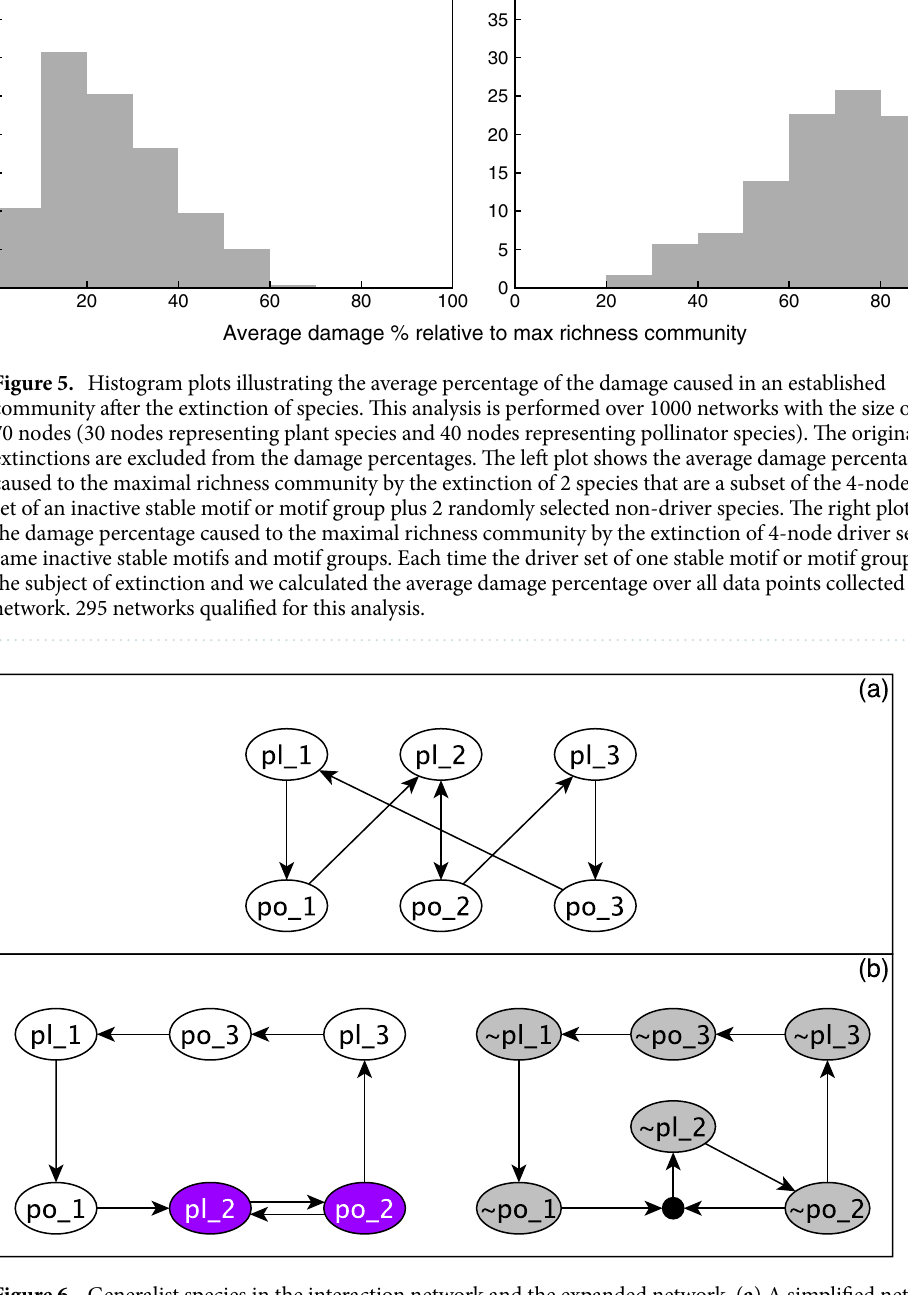
Figure 6. Generalist species in the interaction network and the expanded network. ( a ) A simplified network consisting of 3 plant and 3 pollinator species. pl_2 is a generalist species, i.e., it has two incoming edges indicating that it can survive on either of its sources of pollination, po_1 or po_2. The expanded network in ( b ) illustrates that the stabilization of the grey stable motif stabilizes all the nodes to their inactive states, and hence causes full community collapse. ∼ pl_2 is the minimal driver set of the grey stable motif, consistent with the strong damage induced by the loss of a generalist